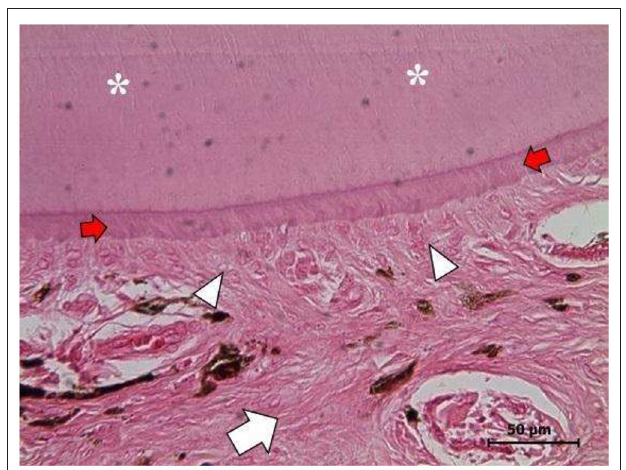
FIGURE 5 | Right ovary. Mature well-differentiated teratoma exhibiting a dentine-pulp complex: dentine filaments (asterisks), pre-dentine zone (red arrows), the odontoblast layer (white arrowheads), and the pulp zone (white arrow). (H&E staining, 1,000X). Scale bars: 50 µ